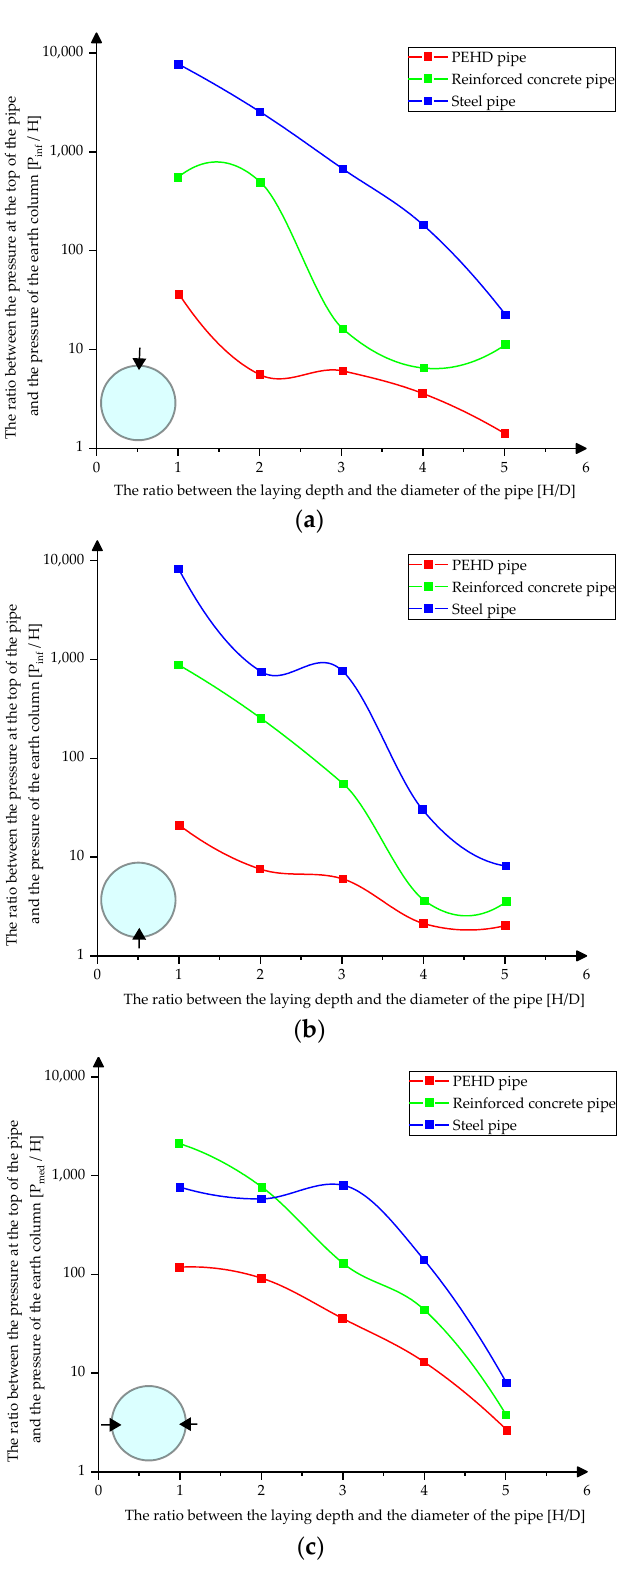
Figure 9. Variation of pressures on pipes in loose sands ( a ) at the top of the pipes ( b ) at the bottom of the pipes. Figure 10a – c presents the variation of the pressures at the upper, lower, and middle part of the pipes depending on their laying depth in compacted sand.